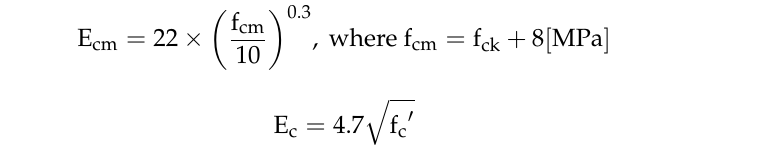
Table 4. Predicted values for the static modulus of elasticity as function of the compressive strength.